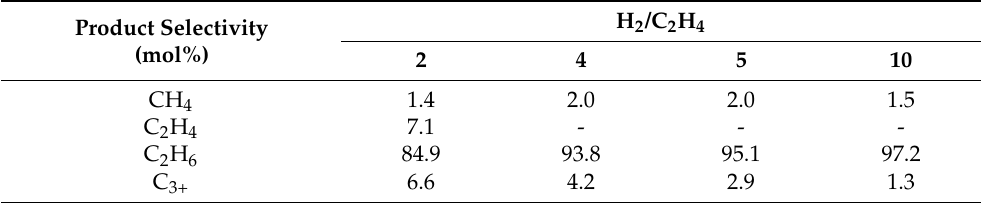
Table 1. C 2 H 4 reaction in H 2 atmosphere (T = 533 K, p = 0.8 MPa).